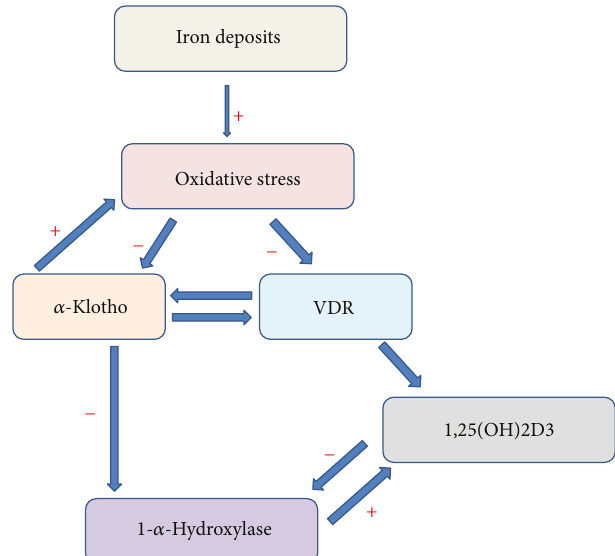
Figure 9: Suggested mechanism for the renal proximal convoluted tubule (PCT) injury in Hp 2-2 DN. The increased iron deposits in the PCT of the Hp 2-2 genotype generate a prooxidative environment in the kidney, leading to reduced renal expression of α -klotho and VDR proteins accompanied by an increased level of PCT injury. This subsequently interferes with vitamin D activation by 1- α -hydroxylase in the PCT, thereby increasing the kidney injury and the incidence of DN and its